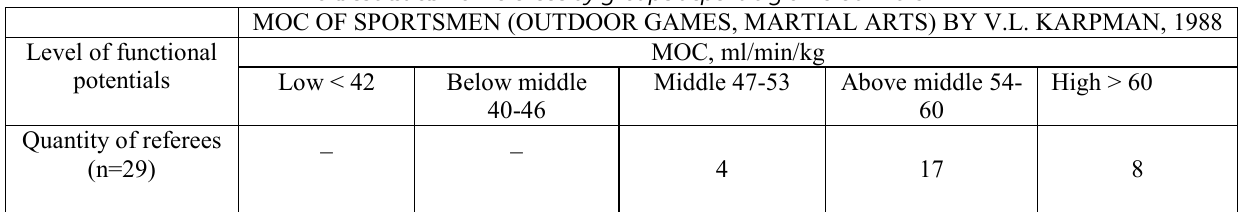
Classification of referees by groups depending on their MOC